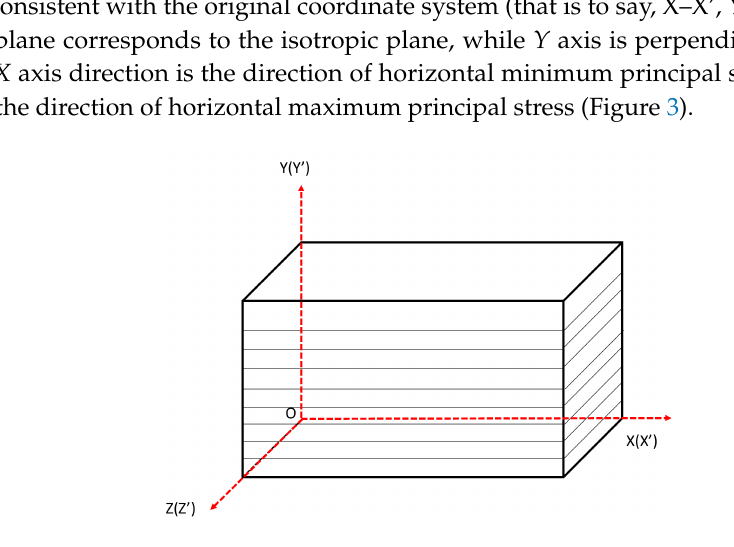
Figure 3. The coordinate system of